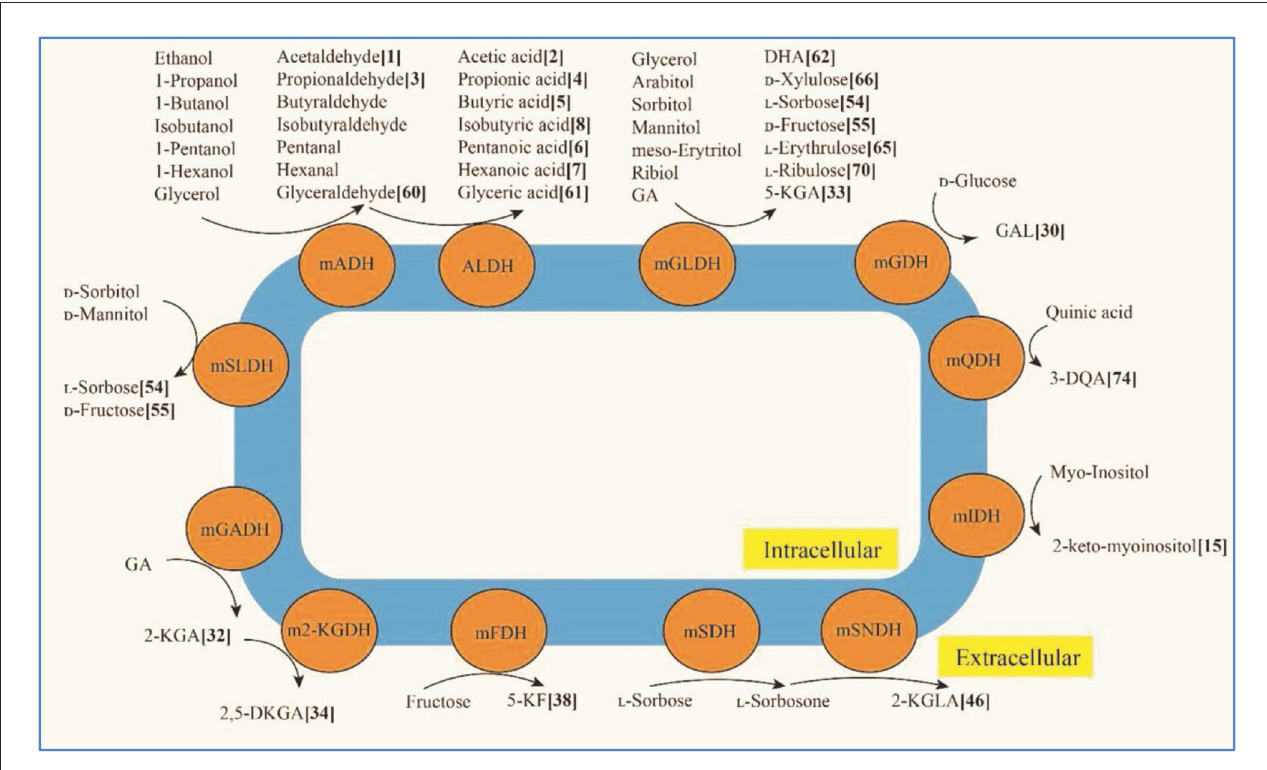
FIGURE1 Figure 3 in He et al.. Typical membrane-binding dehydrogenases in acetic acid bacteria and their main oxidative fermentation products. mADH: membrane-binding alcohol dehydrogenase; mALDH: membrane-binding acetaldehyde dehydrogenase; mGADH: membrane-binding gluconate dehydrogenase; m2-KGDH: membrane-binding 2-keto-D-gluconate dehydrogenase; mFDH: membrane-binding D-fructose dehydrogenase; mSLDH: membrane-binding D-sorbitol dehydrogenase; mGDH: membrane-binding glucose dehydrogenase; mGLDH: membrane-binding glycerol dehydrogenase; mQDH: membrane-binding quinic acid dehydrogenasw; mIDH: membranebinding inositol dehydrogenase; mSDH: membrane-binding sorbose dehydrogenase; mSNDH: membrane-binding sorbone dehydrogenase; GA: gluconic acid; 2-KGA: 2-keto-Dgluconic acid; 2, 5-DKGA: 2, 5-diketo-D-gluconic acid; 5-KF: 5-keto-D-fructose; DHA: dihydroxyacetone; 3-QDA: 3-dehydroquinic acid; 2-KGLA: 2-keto-l-gulonic